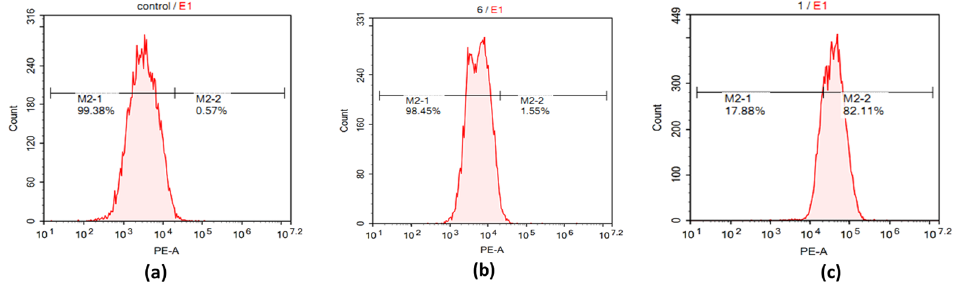
Figure 6. Flowcytometry analysis of labelled MCF-7 cells incubated with the negative control ( a ), YVO 4 :Eu 3+ @silica-NH 2 nanoparticles ( b ), and YVO 4 :Eu 3+ @silica-NH-GDA-IgG nanoparticles ( c ).